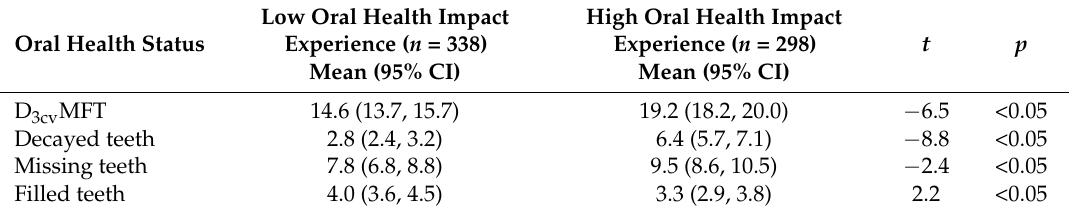
Table 4. Comparison of low and high oral impact experience with obvious decay experience.